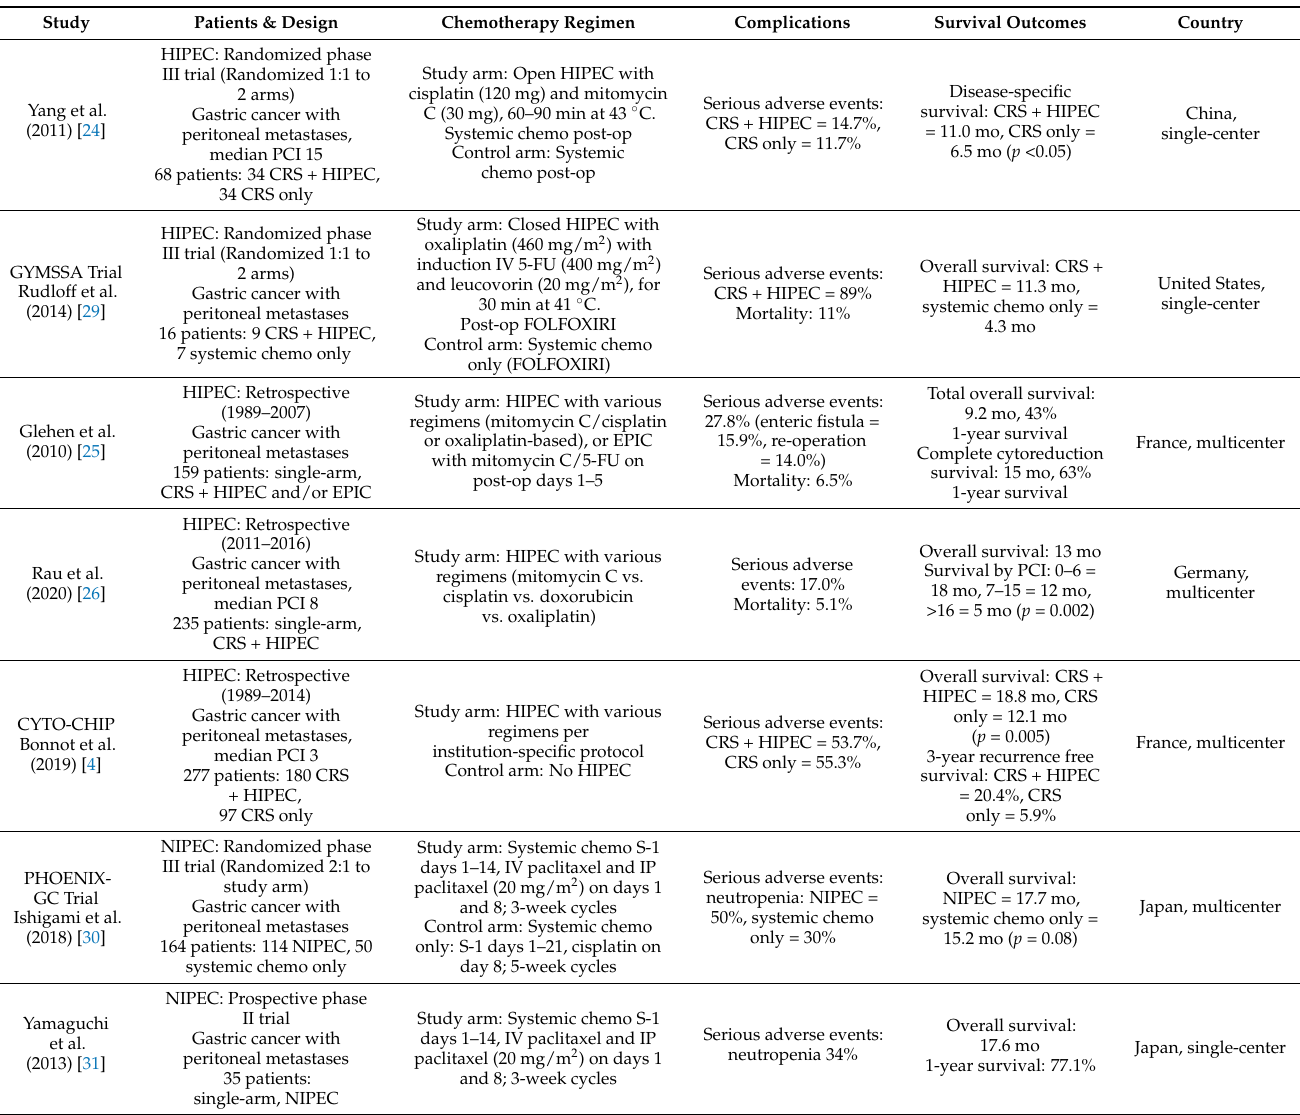
Table 1. Summary of Studies on Hyperthermic and Normothermic Intraperitoneal Chemotherapy in Gastric Cancer with Peritoneal